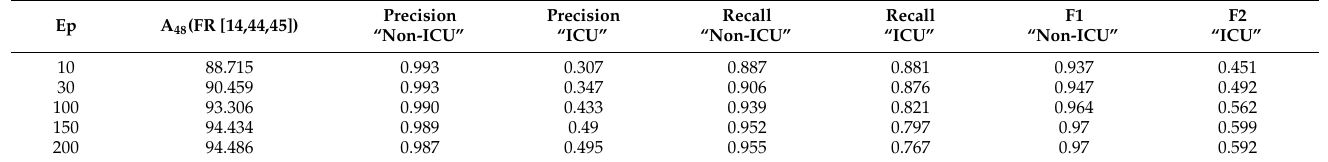
Table 8. Classification metrics depending on the number of training epochs Ep .